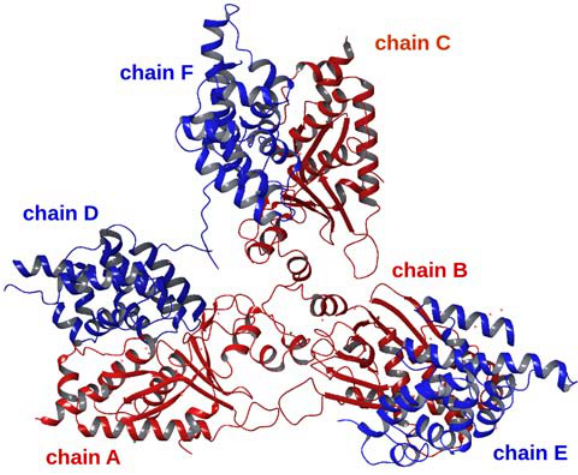
Figure 2 : The complex between the viral VP24 and human KP- NA5C